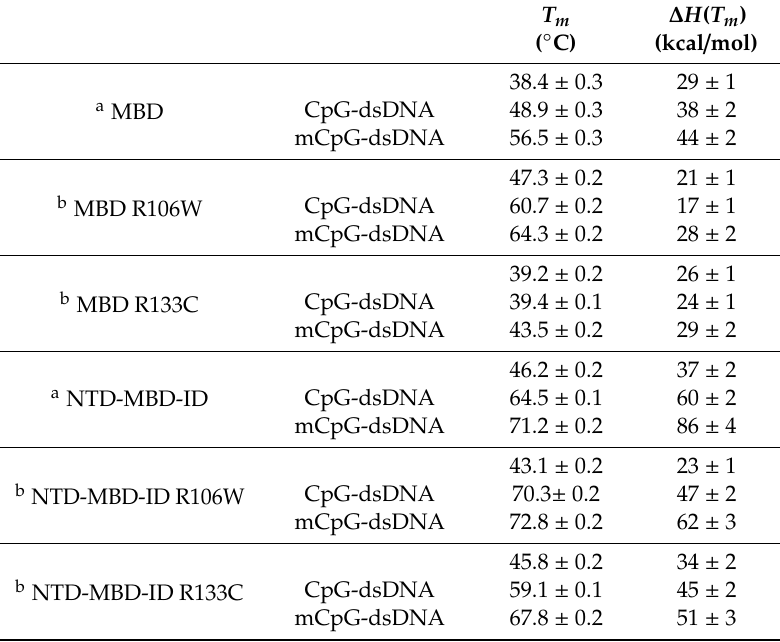
Table 2. Thermal stability of the di ff erent MeCP2 variants in the presence of unmethylated (CpG-) and methylated (mCpG-) dsDNA at pH 7.